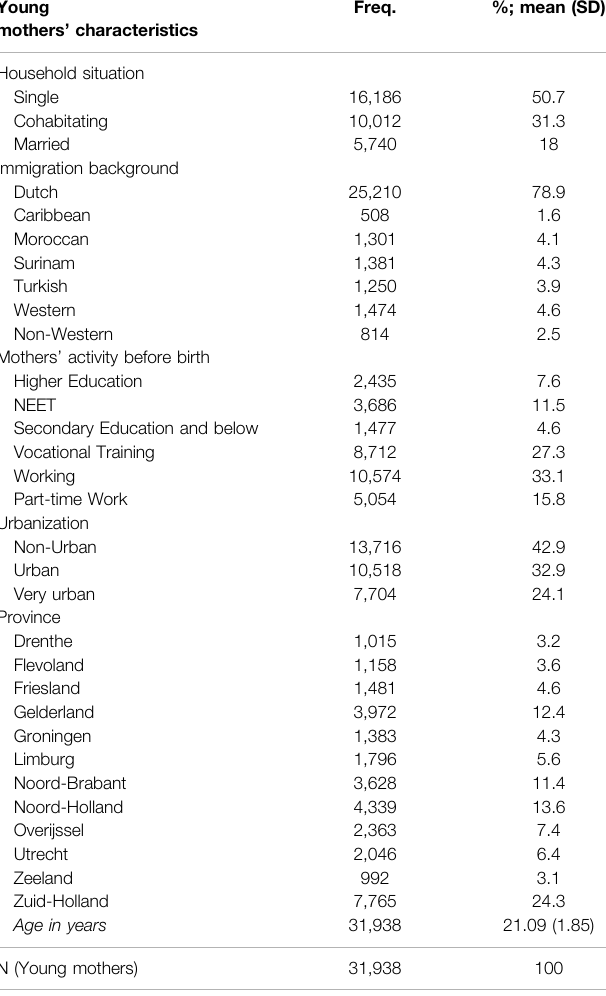
TABLE 2 | Summary statistics of key variables of partners of young mothers. Partner